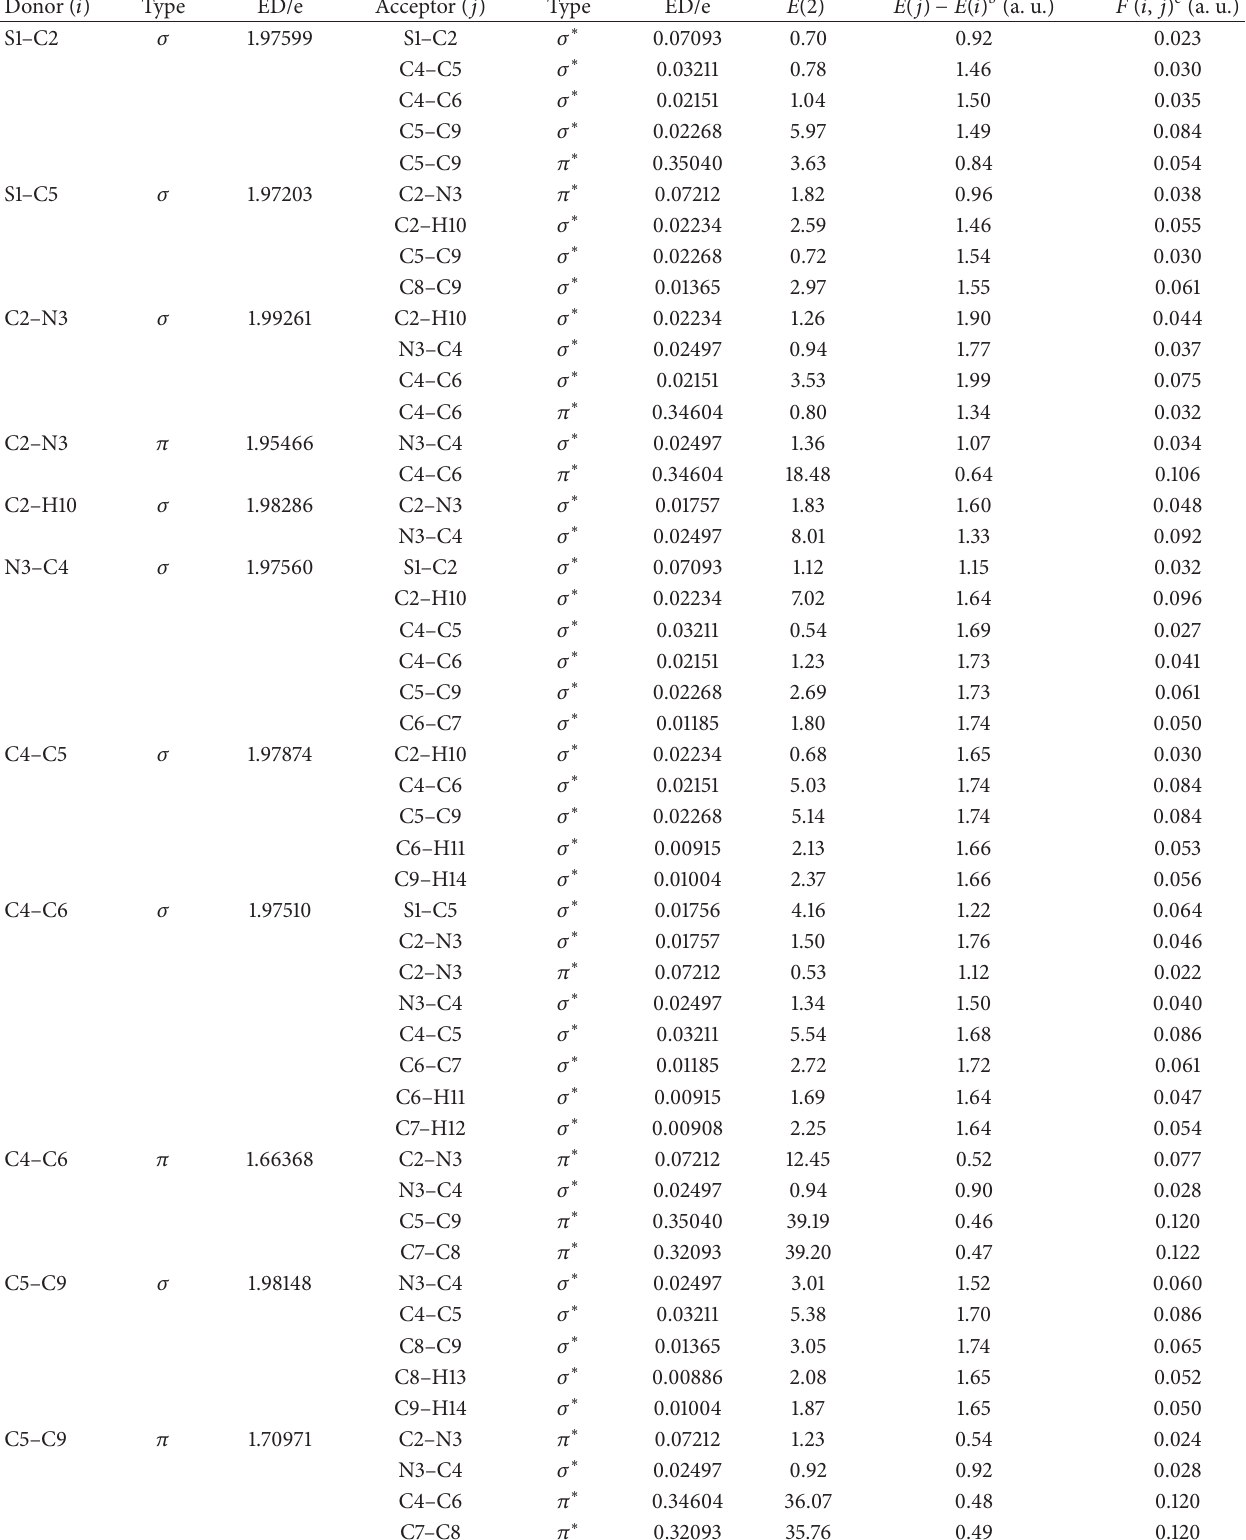
Table 4: Second-order perturbation theory analysis of Fock matrix in NBO basis for